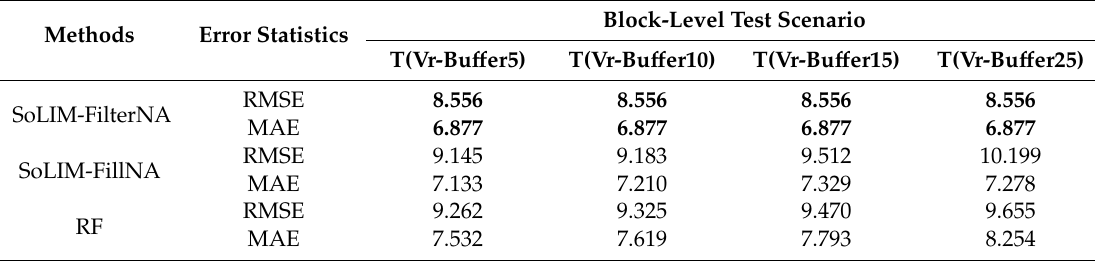
Table 4. Error statistics of the top-layer SOM (g / kg) predicted by di ff erent methods under block-level test scenarios, evaluated based on 109 independent evaluation